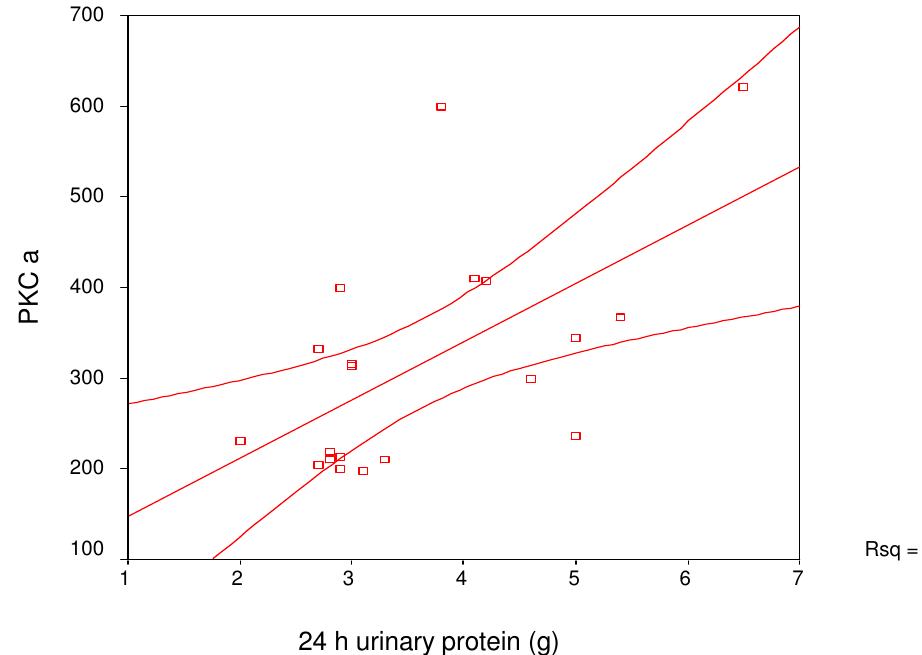
FIGURE 5. Correlation analysis between renal PKC α gene levels ( µ g/ml) and the 24-h urinary protein excretion rate (g/day) in patients with diabetic